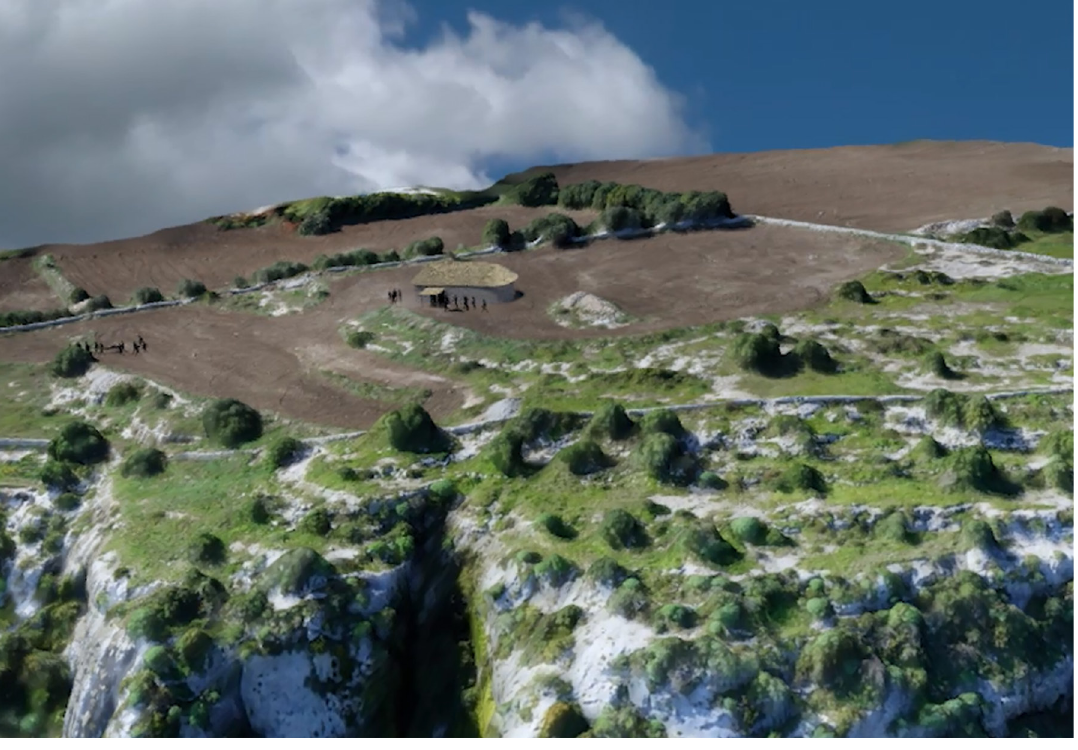
Figure 16. Virtual 3D scenario with the Blender rendering of the